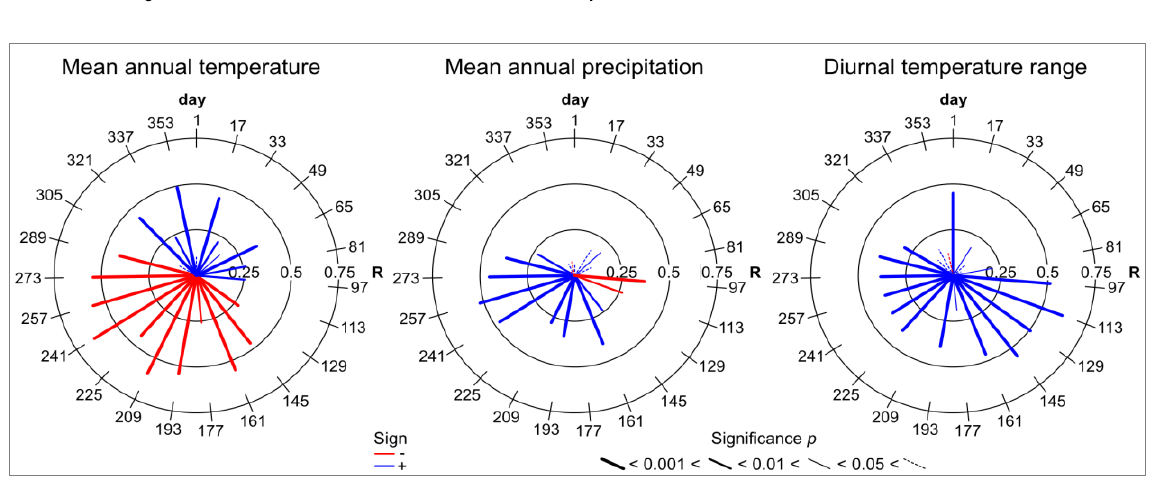
Figure 5. Correlation coefficients for correlations between the NDVI on different dates (Julian days) and three climatic variables (composite